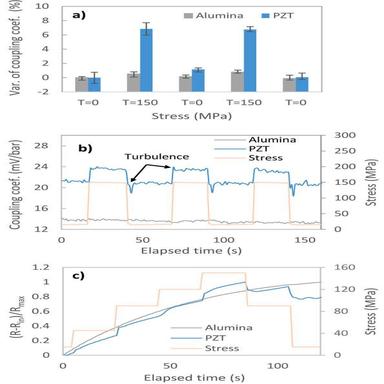
Experimental results illustrating the effect of applied stress on the electric responses of piezoelectric (PZT) and non-piezoelectric (alumina) samples (see Section 4.1). (a) Depicts variation of the coupling coefficients with applied stress in ordinary streaming potential experiments. Notably, the coupling coefficient of the PZT sample changes significantly with stress, while the alumina sample remains unaffected. (b) Shows the variation of coupling coefficients in continuous streaming potential measuremen